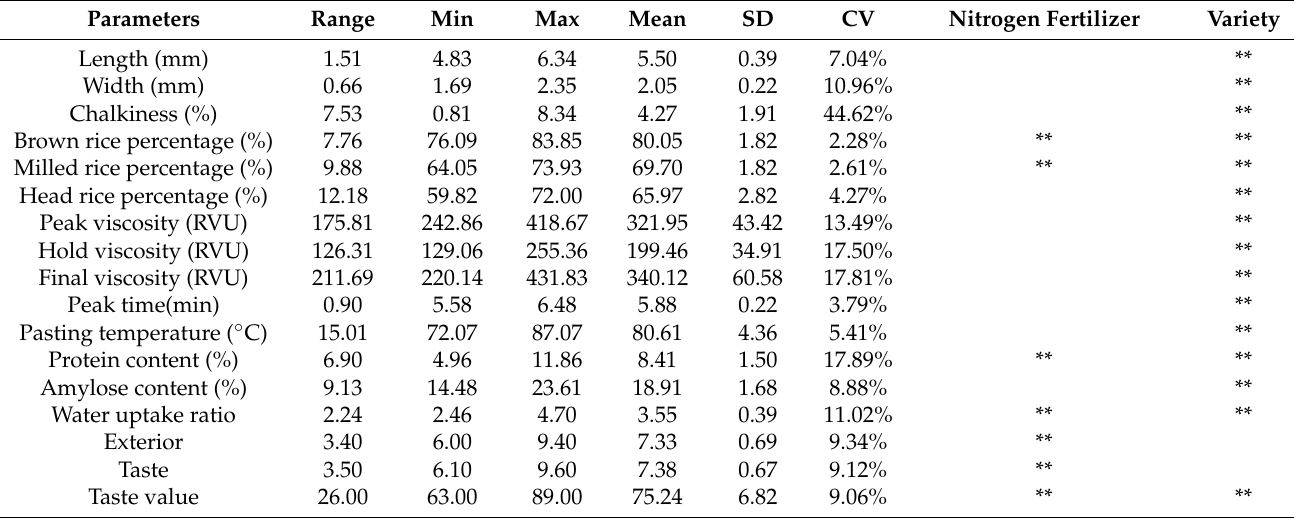
Table 1. Descriptive statistics of rice quality